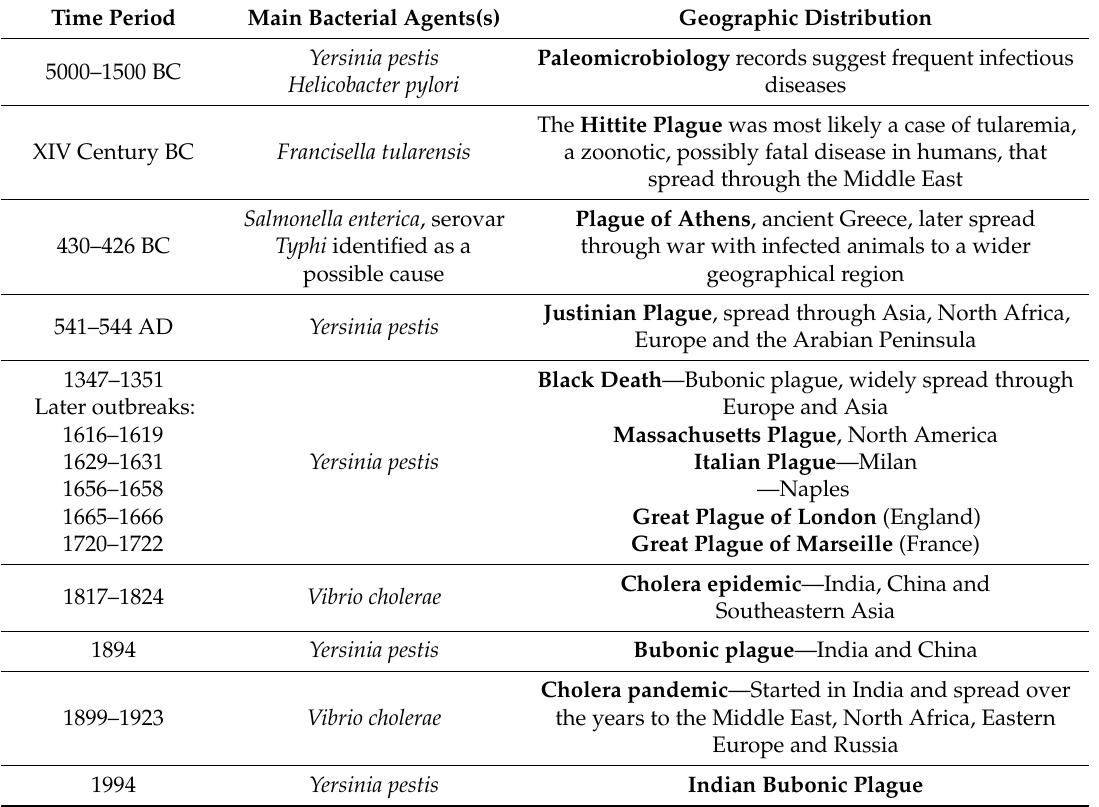
Table 1. Records of widespread human bacterial